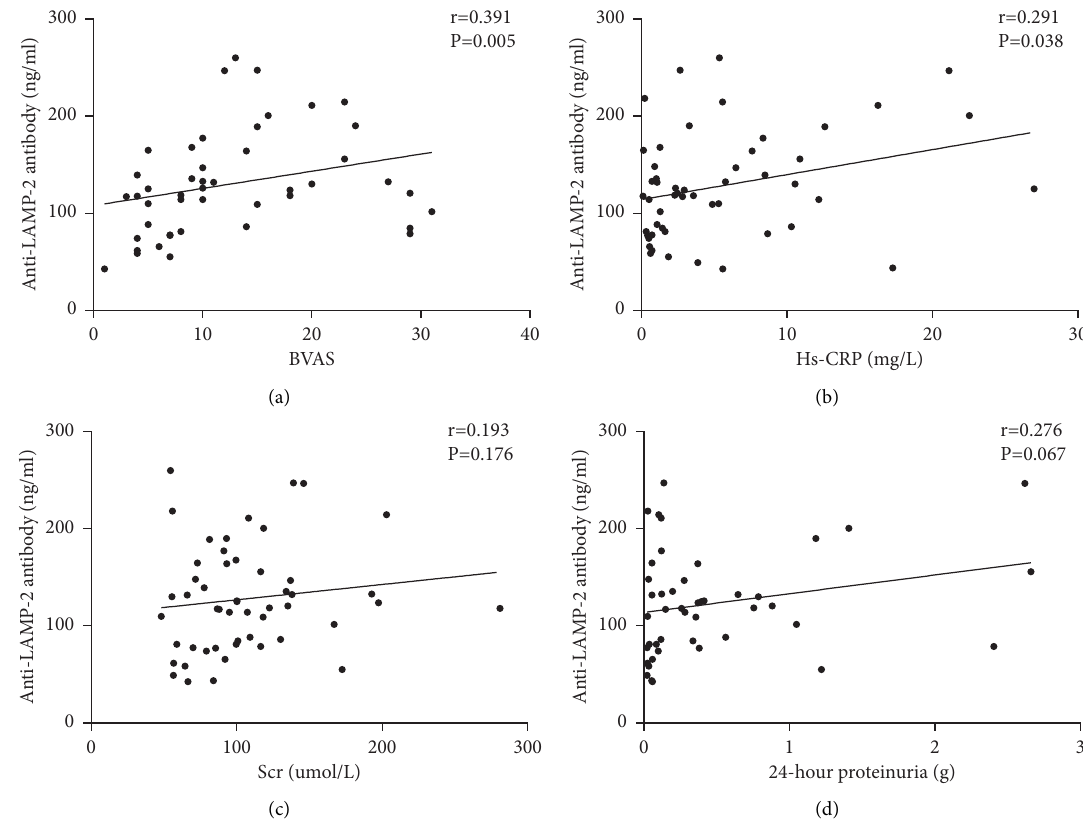
Figure 4: Correlations of anti-LAMP-2 antibody levels with BVAS, Hs-CRP, Scr, and 24-hour proteinuria in patients with vasculitis combined with hypertension.